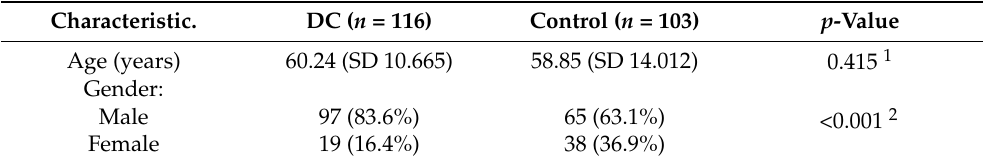
Table 1. Characteristics of study